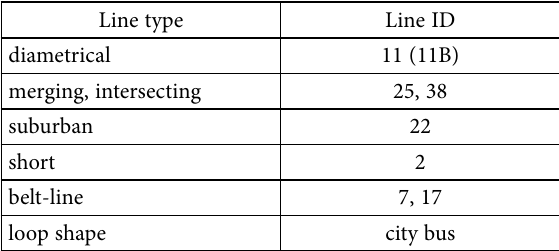
Table 1. Selected line types and line IDs ( source : research by the authors)